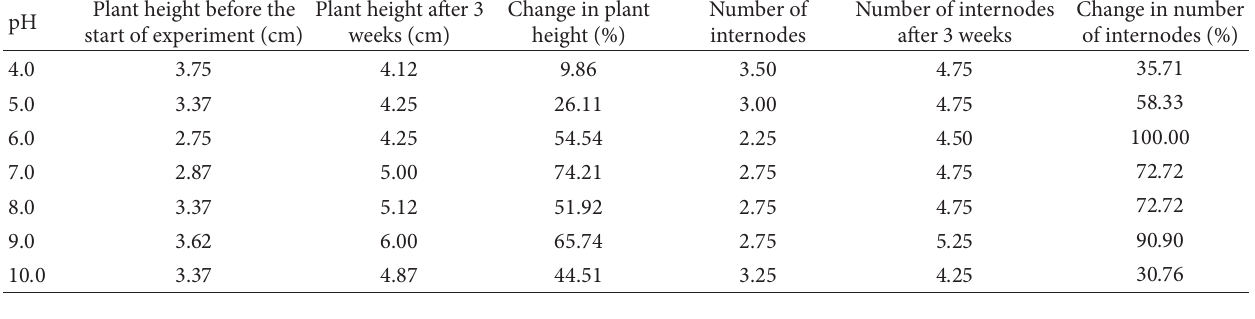
Table 3: Effects of pH levels on plant height and number of internodes of H. polysperma .